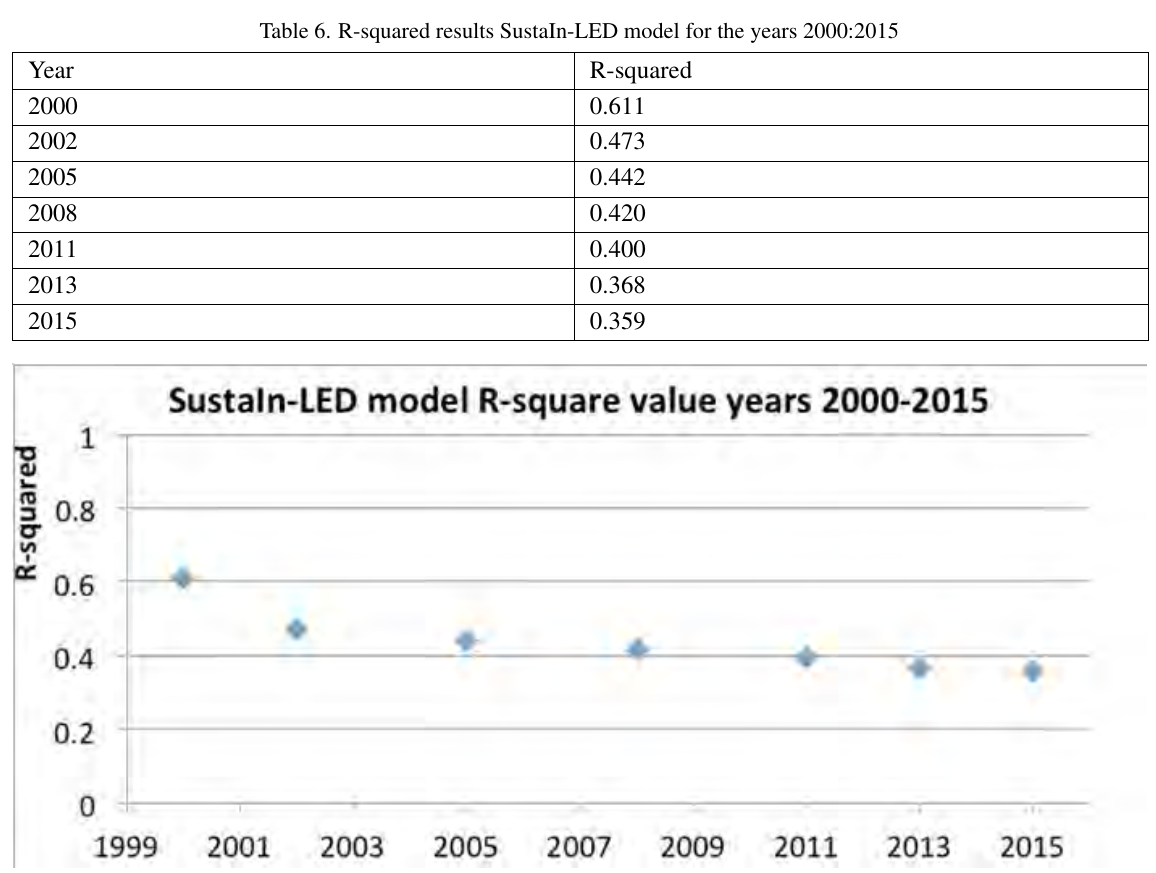
Figure 1. R-squared coefficient from the linear regressions of the SustaIn-LED model in the years 2000-2015 It is probable that the negative trend phenomenon can be explained with the various economic crises that happened during the years taken into account in the